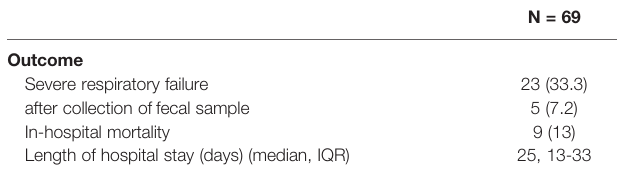
TABLE 1 | Characteristics of study